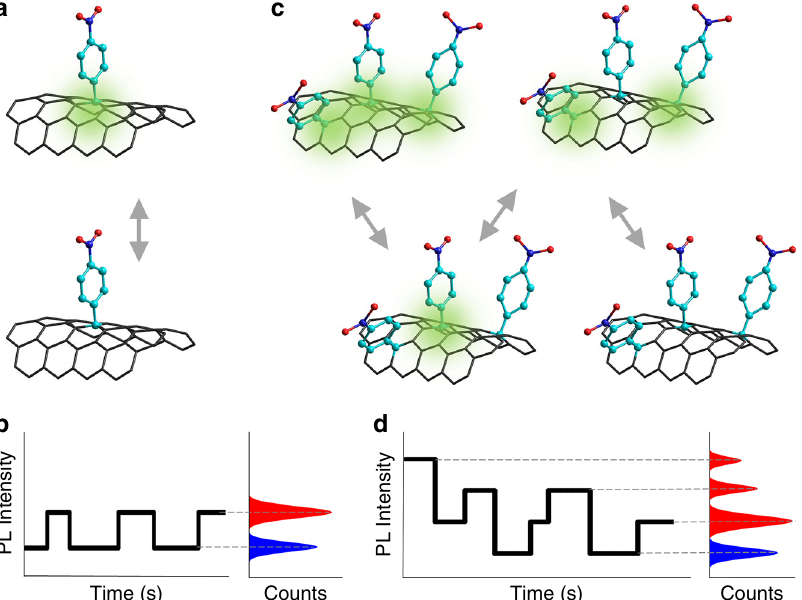
Fig. 1 Counting defects based on photoluminescence (PL) blinking. a Schematic illustration of a single chemical defect that switches between PL on (green shade) and off states due to surface charges. The gray arrows represent reversible PL state switching. b The illustration of PL intensity time trajectory (black solid line) and histogram from a single-defect features two states, PL on and off. The red and blue bells in the histogram represent the distribution of PL intensity of on and off states respectively. Dashed lines are added as a guide to the eye. c For a cluster of defects, each defect randomly turns on and off. d The stochastic blinking of clustered defect PL is collectively shown as multiple intensity